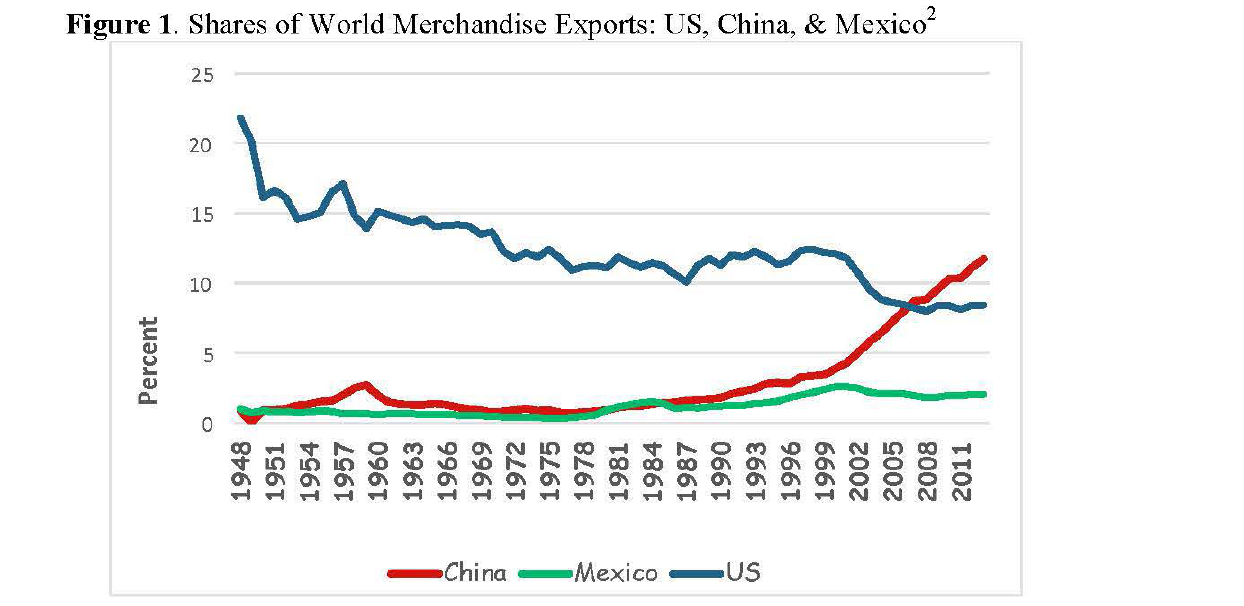
Figure 1. Shares of World Merchandise Exports: US, China, & Mexico